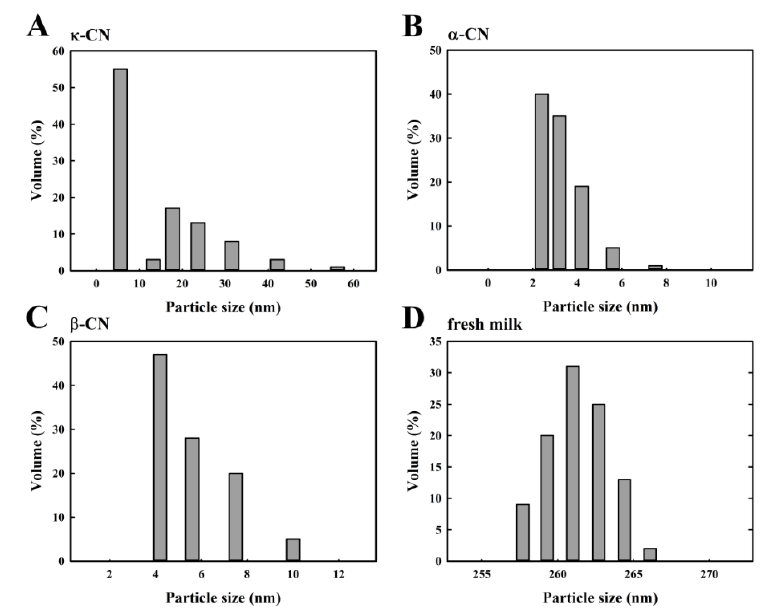
Figure 3. Changes in the particle size distribution of milk proteins without MTGase. ( A ) κ -CN; ( B ) α S -CN; ( C ) β -CN; ( D ) fresh milk. The z-average diameter of the colloidal dispersions was measured using a nanoparticle analyzer. Samples were diluted with a buffer (pH 6.8) prior to measurements to avoid multiple scattering effects.